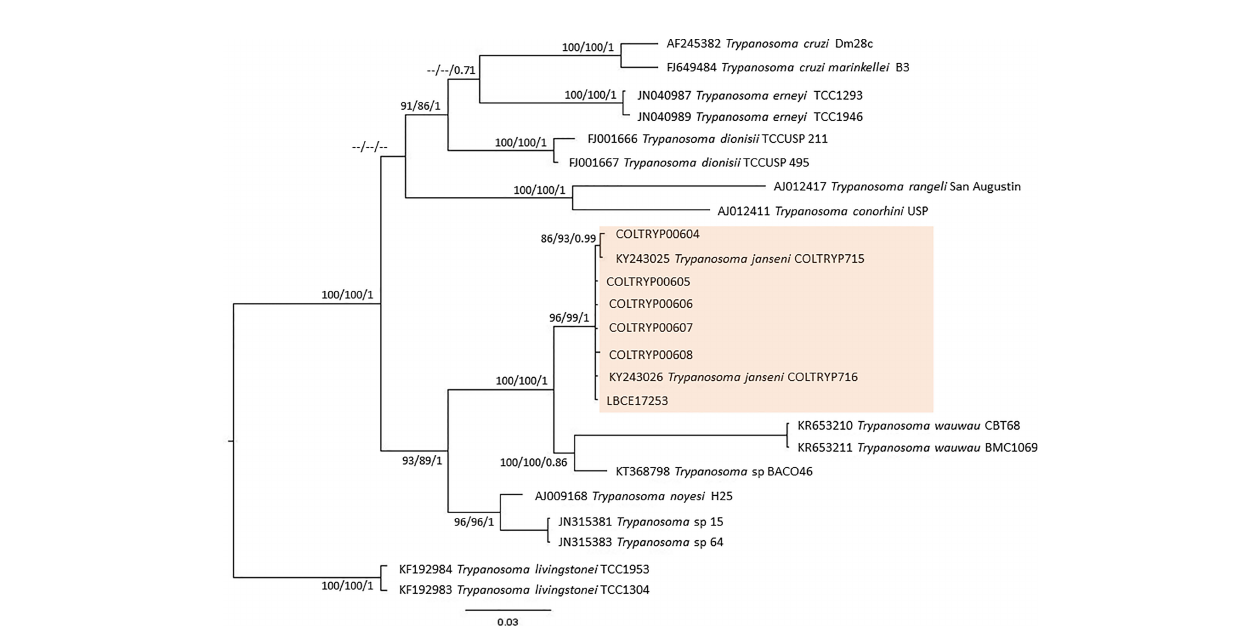
FIGURE 2 | Concatenated (SSU rDNA + gGAPDH) T. cruzi clade phylogenetic tree based on 1121 base pair fragment lengths of sylvatic mammal hemocultures. The tree was inferred using transitional3 equal frequencies plus gamma distribution (TIM3e+G) and generalized time reversible with invariant sites and amino acid frequencies plus gamma distribution (GTR+F+I+G) models for ML and BI, respectively. The numbers at nodes correspond to ML (ultrabootstrap, SH-aLRT) and BI (posterior probability). The scale bar shows the number of nucleotide substitutions per site. The red square represents group formed T. janseni sequences from different culture